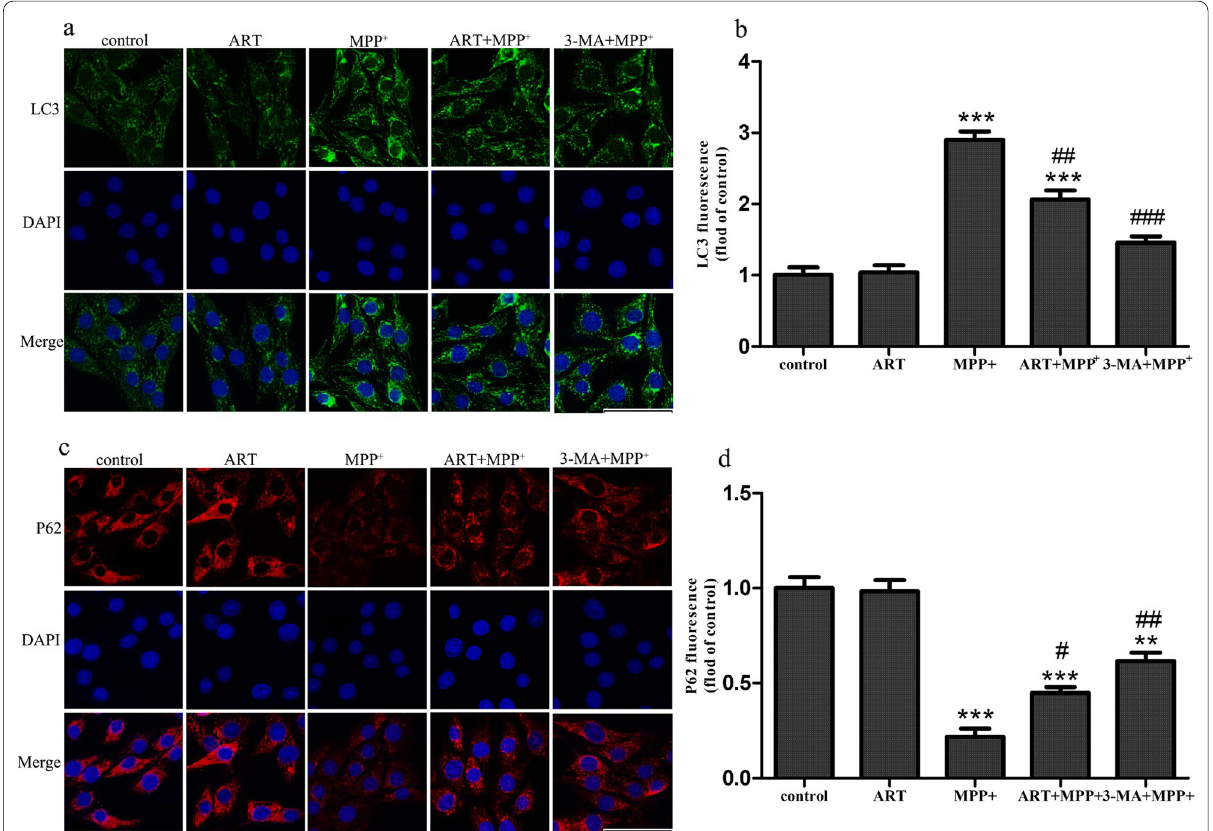
Fig. 6 The protein expression of LC3 based on immunofluorescence staining ( a ), and the fluorescence intensity was analyzed by ImageJ ( b ). The protein expression of p62 based on immunofluorescence staining ( c ) and the fluorescence intensity was analyzed by ImageJ ( d ). The fluorescence intensity of the control group was set to 1, and the fluorescence intensity of the other groups was compared with that of the control group. The data are presented as the mean SD (n 3), Scale bar 50 μm. * p < 0.05, ** p < 0.01, *** p < 0.001 vs. control; # p < 0.05, ## p < 0.01 vs. MPP ± = =